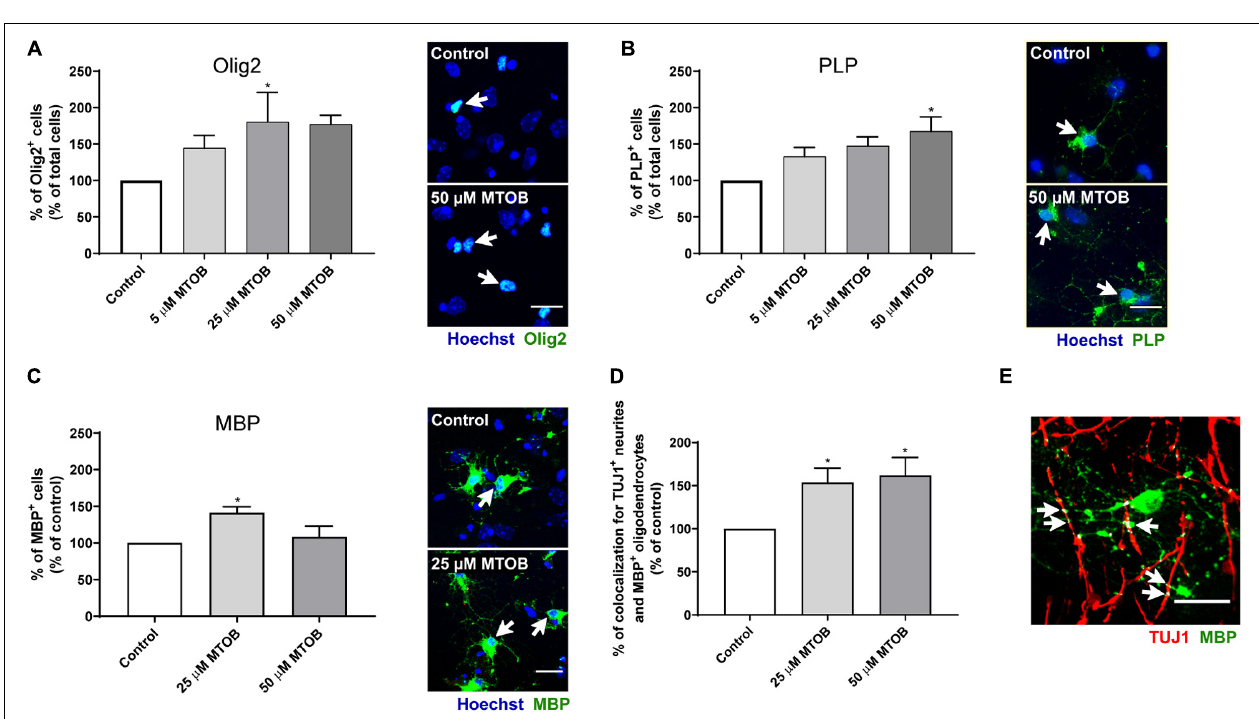
FIGURE 6 | CtBP modulation promotes the differentiation of progenitor cells into neurons. (A,B) Bar graph depicts the percentage of (A) NeuN-immunostained mature neurons and (B) GFAP-immunostained astrocytes, maintained in culture for 7 days after MTOB treatments. Data are expressed as percentage of control ± SEM. (A) n = 5–7 and (B) n = 3 independent experiments. Control was set to 100%. * p < 0.05 and ** p < 0.01 when compared with control, using one-way ANOVA, followed by Dunnett’s multiple comparison test. Representative confocal images of NeuN and GFAP immunostainings are shown next to the graphs, with white arrows highlighting staining. Nuclei are stained with Hoechst. Scale bar: 20 µ m.